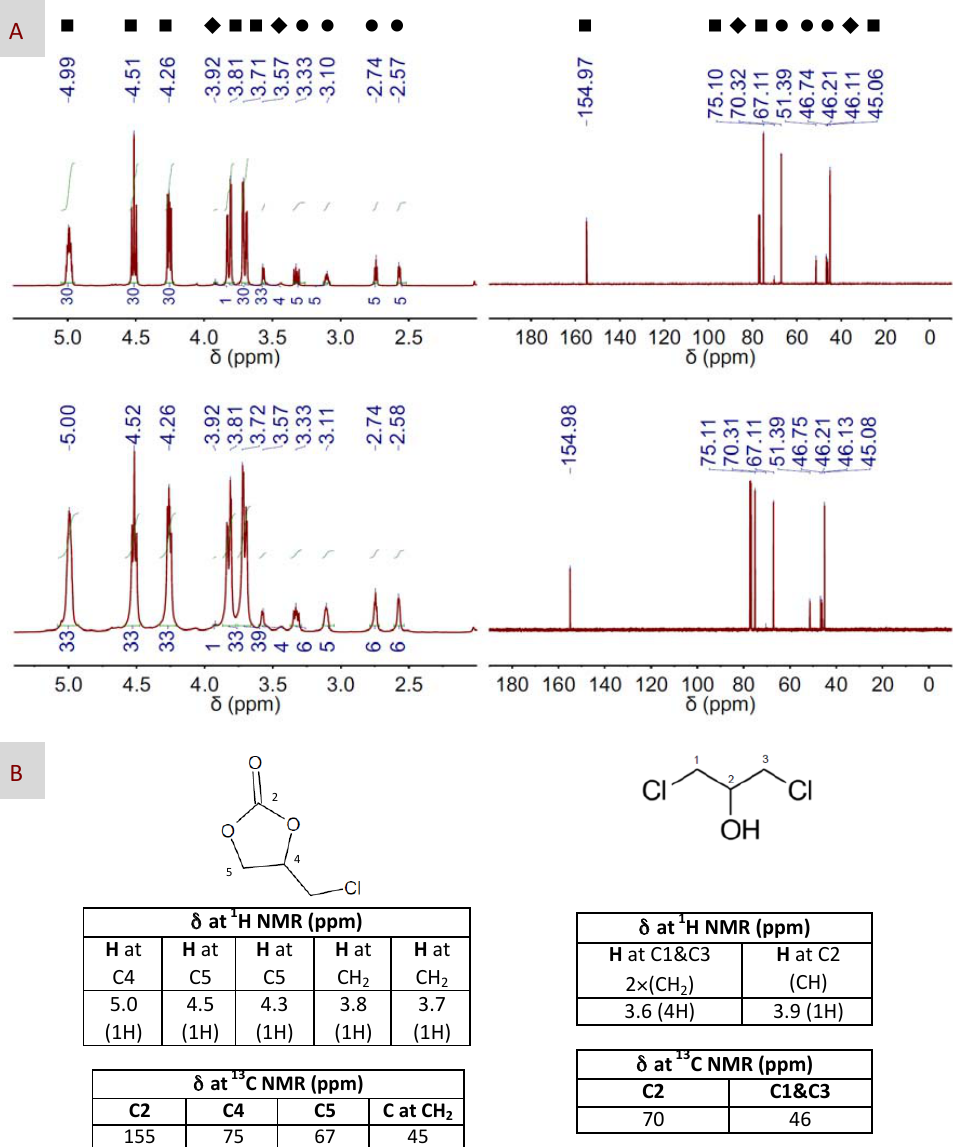
Figure 3. ( A ) 1 H and 13 C NMR spectra (left and right columns, respectively) of both the main product, e.g., 4-(chloromethyl)-1,3-dioxolan-2-one, and the sub-product, e.g., 1,3-dichloropropan-2-ol, resulting after CO 2 fixation to EP using either DBU (top panel) or DBU(1):BA(1) DES (bottom panel) as the catalyst. The catalyst to EP molar ratio was 1:100. Symbols assign peaks to their respective molecules, i.e., (cid:4) for 4-(chloromethyl)-1,3-dioxolan-2-one, (cid:7) for 1,3-dichloropropan-2-ol and for EP. ( B ) Chemical structures of 4-(chloromethyl)-1,3-dioxolan-2-one and 1,3-dichloropropan-2-ol, as well as chemical shifts assigned to their respective peaks at the 1 H and 13 C NMR spectra. The reaction conditions were 100 ◦ C, 1.2 bars and 2 h for these particular spectra, but similar spectra were obtained in the different reaction conditions described in Table